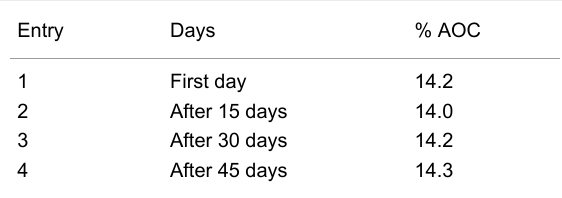
Table 1: Stability study of nonanebis(peroxoic